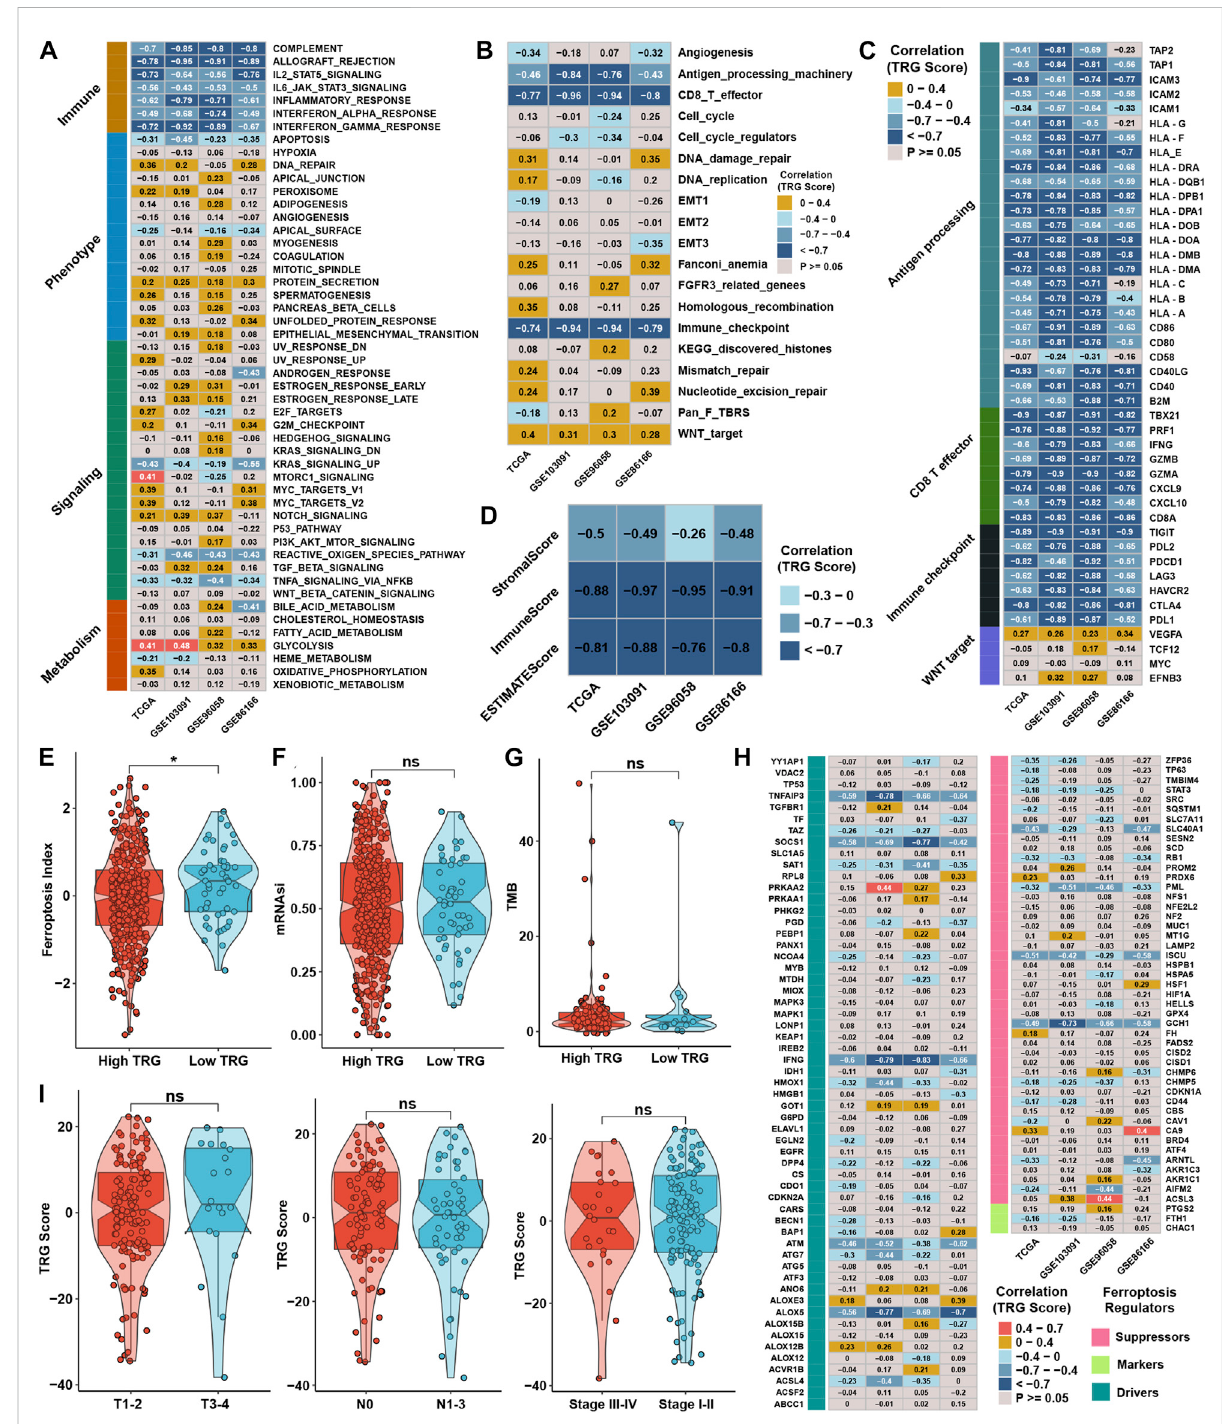
FIGURE 6 Generation of TRG score and functional veri fi cation. (A) Correlation analysis between the GSVA score and TRG score in four TNBC cohorts. (B) Correlation analysisbetweenthecurativepathwayenrichmentscoreandTRGscoreinfourTNBCcohorts. (C) Correlation analysisbetweentheTRG scoreandtheexpressionofgenesinvolvedinfoursigni fi cantpathwaysinSupplementaryFigureS4C. (D) CorrelationanalysisbetweentheTRGscore and theresults ofESTIMATEanalysisin four TNBC cohorts. (E,F) Differences in theresults for FPI and mRNAsi between TRGscore groups inthe wholeTNBCcohort. (G) DifferencesinTMB betweenTRGscoregroupsintheTCGAcohort. (H) Correlation analysisbetweentheTRGscoreandthe expression of 113 ferroptosis-related genes in four TNBC cohorts. (I) Differences in TRG score between different clinical trait groups in the TCGA